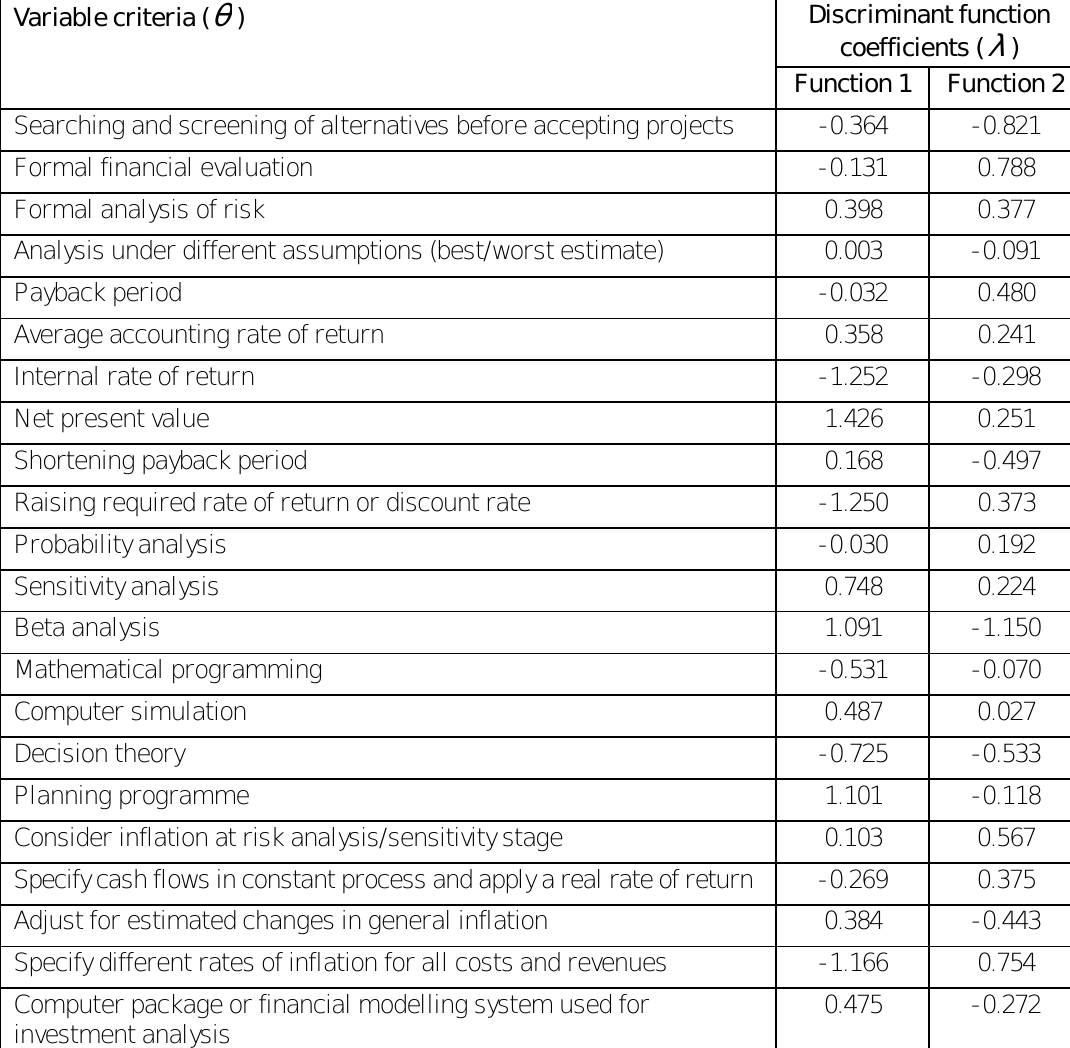
Table 8: Standardised canonical discriminant function coefficients θ Variable criteria (